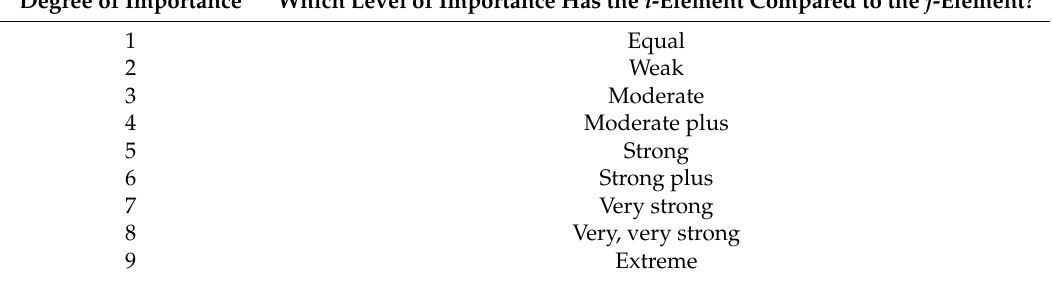
Table 3. Saaty’s semantic